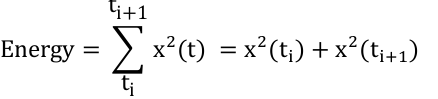
Figure 6. Description of short time Fourier transform